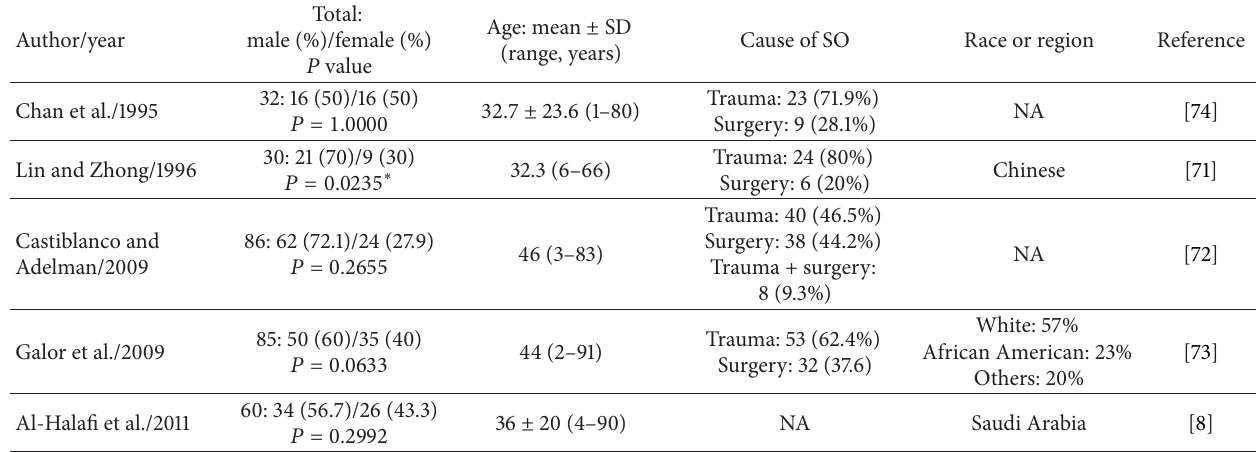
Table 2: Demographic differences of sympathetic ophthalmia (SO) in the